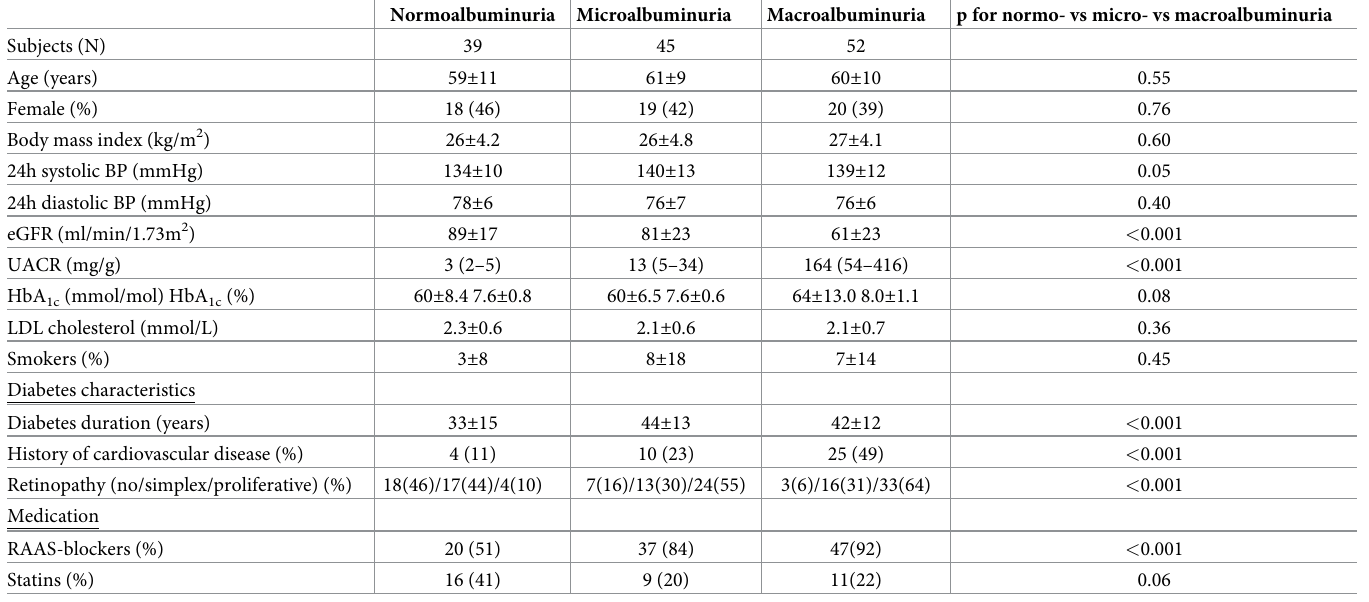
Table 3. Clinical characteristics of the participants categorized into normo-, micro- and macroalbuminuria.